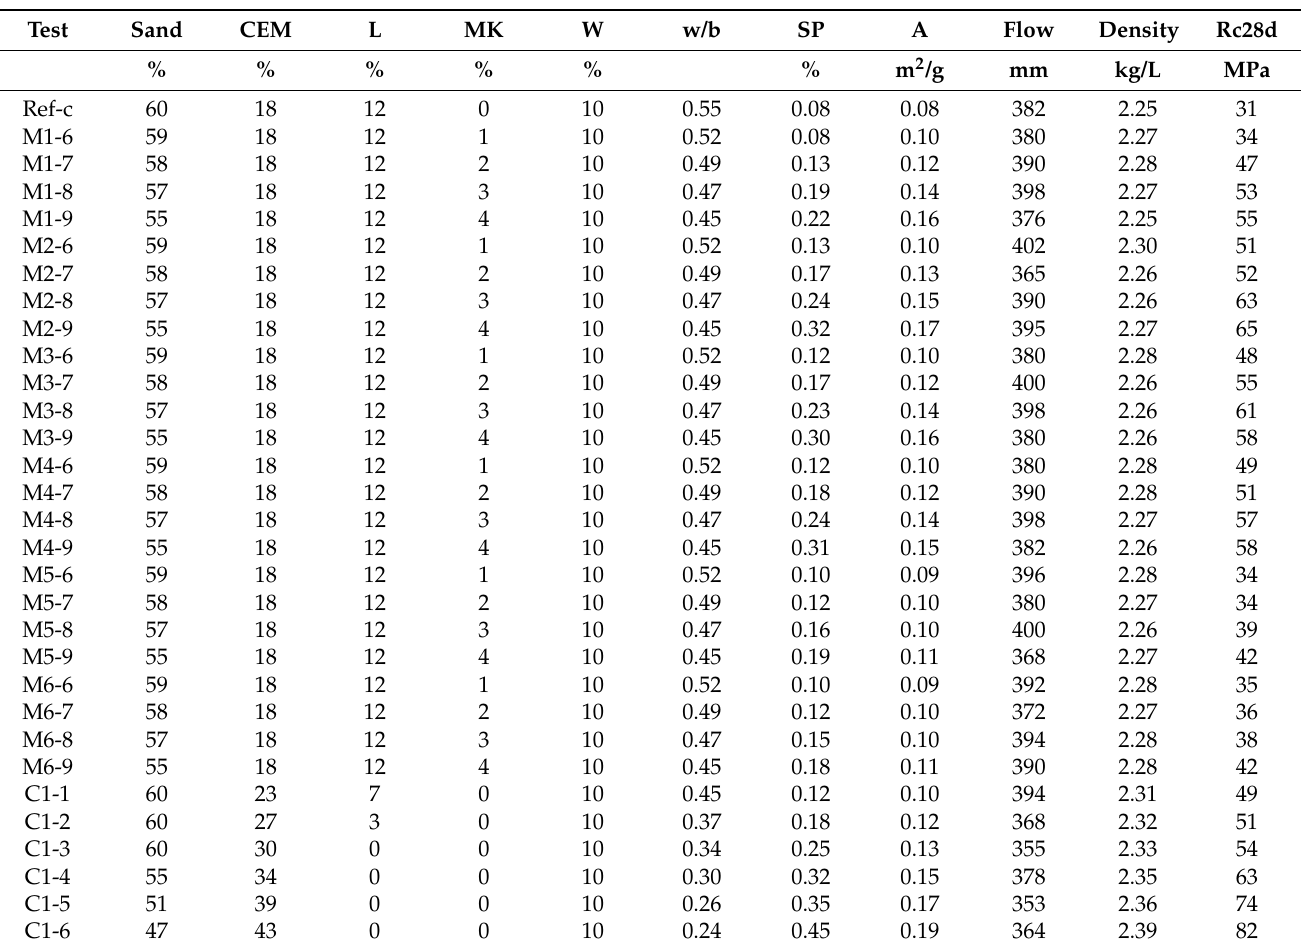
Table 8. Formulations of the mortars prepared with different contents as weight percentage of sand, cement (CEM), GCC (L), metakaolin (MK) and water (W) given as mass percentage. The calculated water-to-binder ratio (CEM + MK), superplasticizer dosage (% of the total mix) (SP) and corresponding surface area (A) values are presented, as well as the slump tests without shock (Flow), the medium density and compressive strength at 28 days